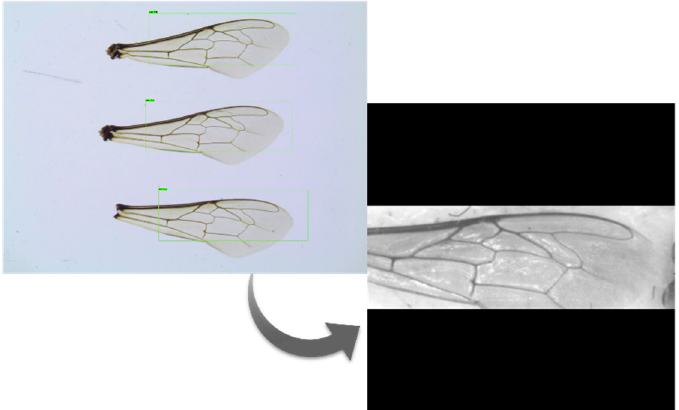
Figure 7. An example illustrating the end product of the preprocessing stage of a typical multi-wing image.